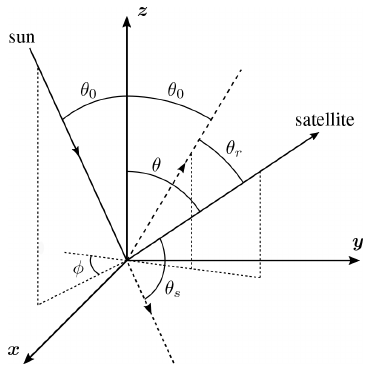
Figure 1. Angle definition at the surface: solar zenith angle θ 0 , viewing zenith angle θ , relative azimuth angle φ , scattering angle θ s , and reflected Sun angle θ r . Zenith is towards z